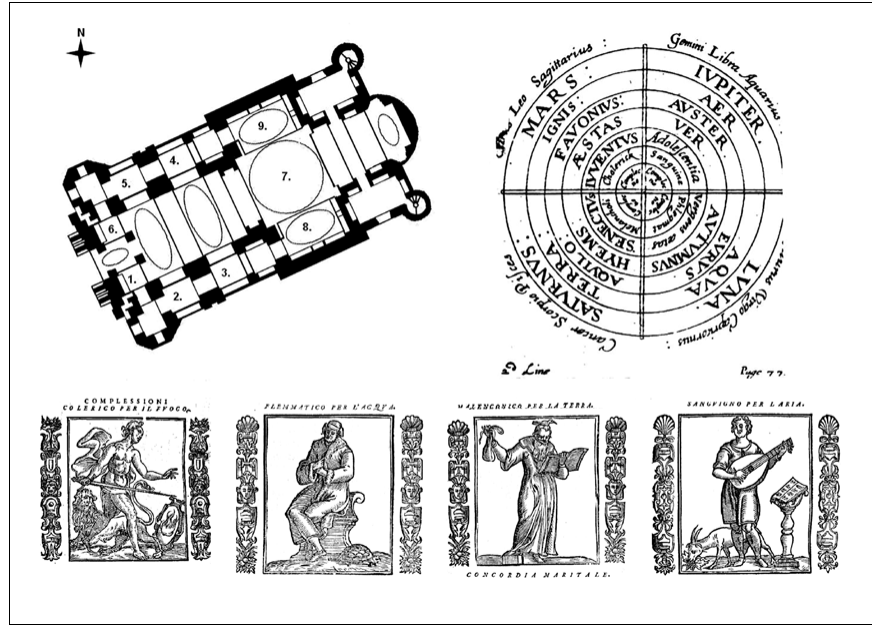
fig. 8. The elevation of St. Peter and St. Paul’s Church: 1) the statue of Death; 2) the chapel of Holy Warriors; 3) the chapel of St. ursula and Virgin Martyrs; 4) the chapel of St. augustine; 5) the chapel of Holy Queens; 6) the baptistery; 7) the dome; 8) the altar of five Wounds of Christ; 9) the altar of Gracious Mary.